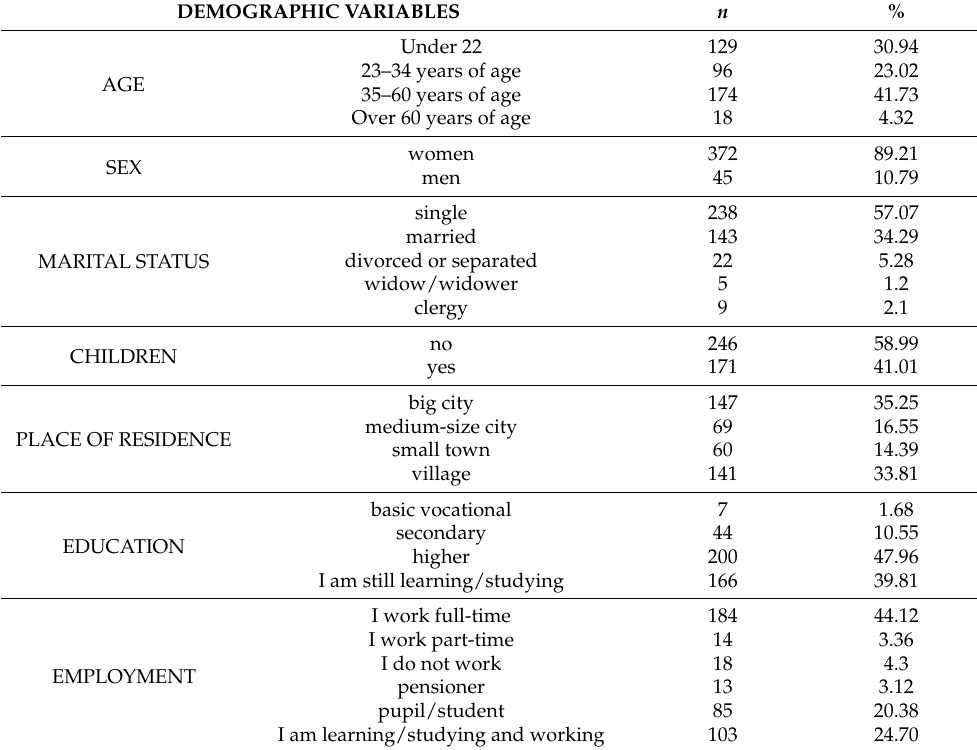
Table 1. Characteristics of study